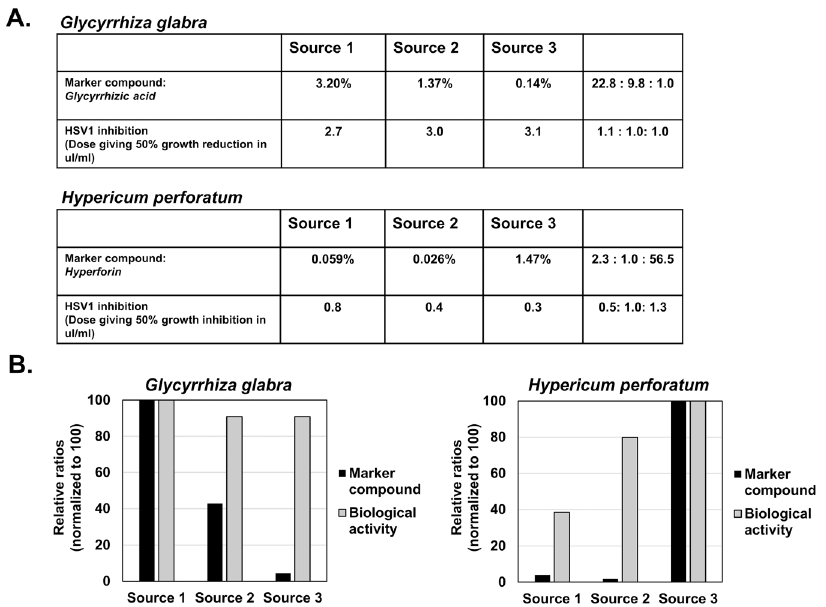
Fig 1. Marker compound level and bioactivity of antiviral herbs. Part A) Marker compound level (percent of total weight) of glycyrrhizic acid (from G . glabra) and hyperforin (from H . perforatum) and HSV-1 ID 50 values ( μ l/ml) are shown from three commercial sources. Part B) Marker compound ratios and bioactivity ratios were normalized to 100 (max. level) and graphed.